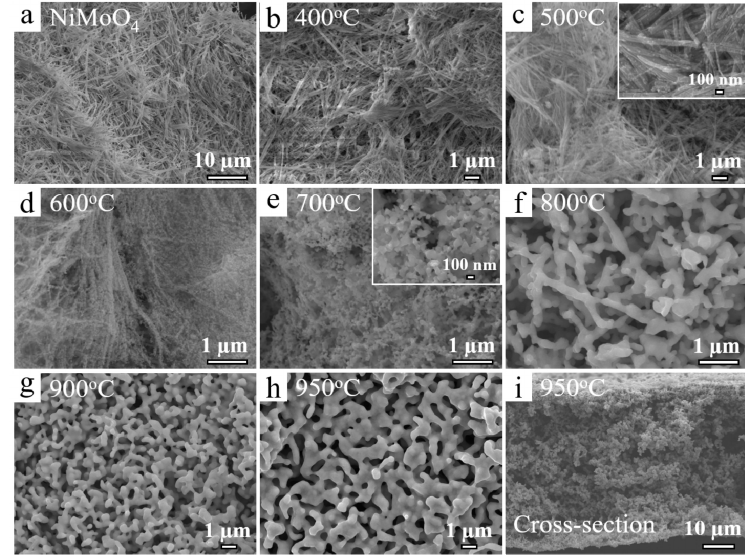
Figure 2. SEM images of ( a ) pristine NiMoO 4 nanofiber; ( b – i ) temperature effect of 3D porous